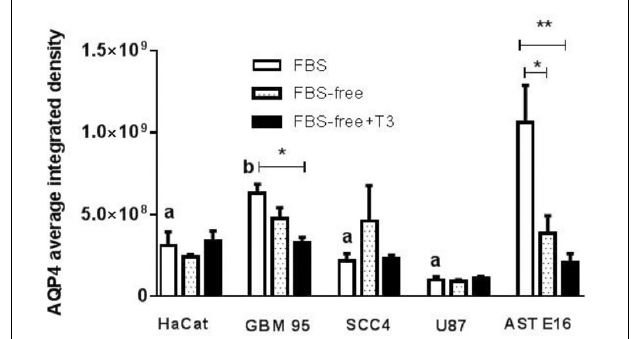
FIGURE 4 | Fluorescence analysis for AQP4 in HaCat, GBM-95, SCC-4, and U-87 cell lines and a secondary culture of astrocytes (AST E16). The integrated density is the sum of the values of the pixels in the area considered fluorescent. T3 treatment significantly downregulated AQP4 in GBM-95 cells maintained in FBS. Among all the cell lines examined, astrocytes exhibited the highest expression of AQP4. T3 treatment in FBS-free medium reduced AQP4 expression in astrocytes. HaCat, SCC-4, and U87 cell lines showed no change in AQP4 expression. Cells were cultured in medium containing 10% FBS, medium without serum (FBS-free), and treated with T3 in medium without serum (FBS-free+T3). ∗ P < 0.05, ∗∗ P < 0.01, ∗∗∗ P < 0.001; and (a) P < 0.001; (b) P < 0.05 are related to differences between the tumor cells in FBS medium vs. secondary culture of Ast E16 in FBS.